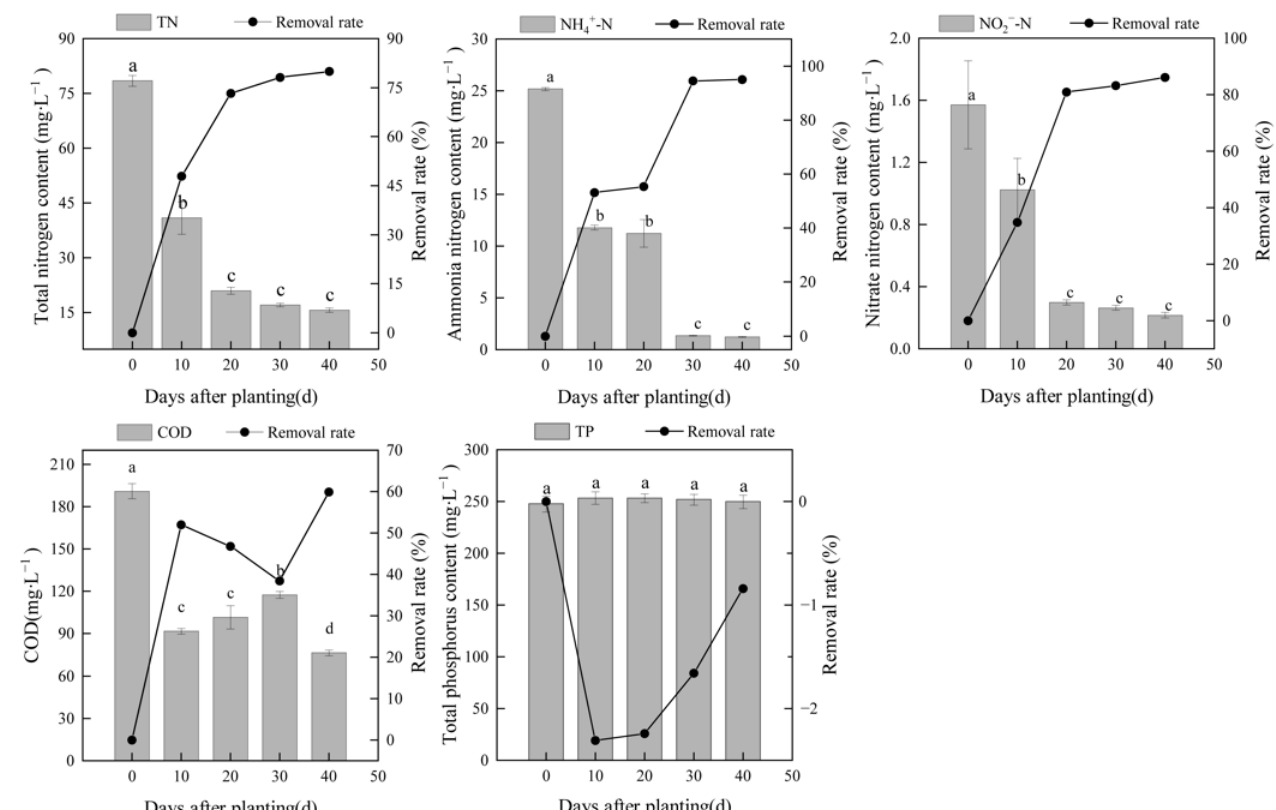
Figure 2. Concentrations and removal rates of TN, NH 4+ -N, NO 2 − -N, TP, and COD in the LW lagoon treated by a substrate- free floating constructed wetland planted with water dropwort. Different letters indicate significant differences between different days after planting ( p < 0.05).